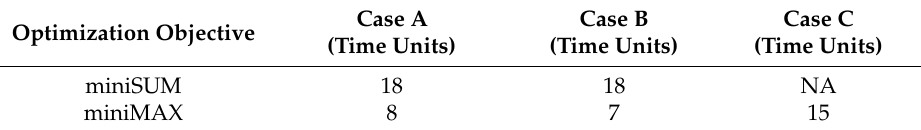
Table 7. Simulation Results.